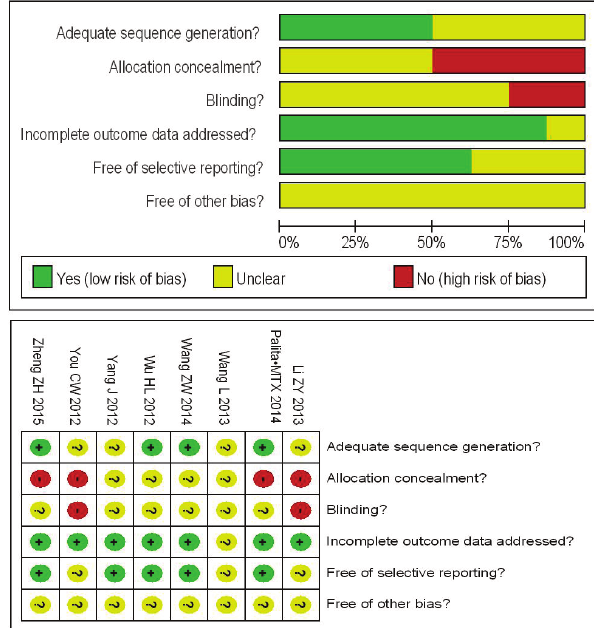
Figure 6. The egger’s line regression test indicated sig- nificant publication bias for complete response (t=5.98, P=0.002) and objective response rate (t=6.23, P=0.003).